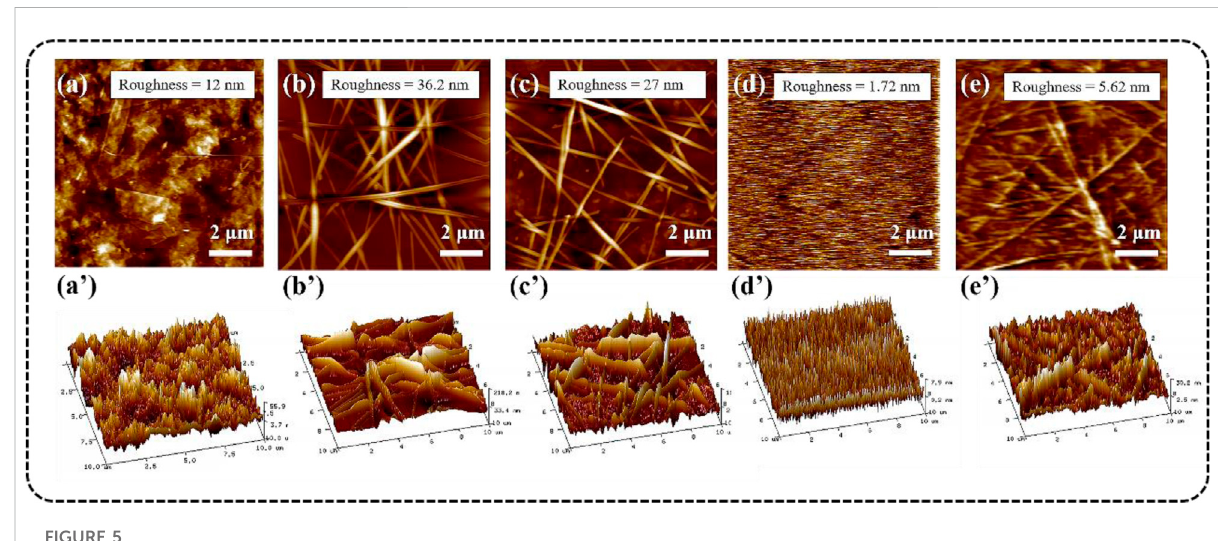
FIGURE 5 AFM(up)and3DAFM(down)imagesofdifferentTCFs: (A-A ’ ) Ti 3 C 2 T x -PET, (B-B ’ ) AgNWs-PET, (C-C ’ ) AgNWs/Ti 3 C 2 T x -PET, (D-D ’ ) FG/PVA,( E-E ’ ) AgNWs/Ti